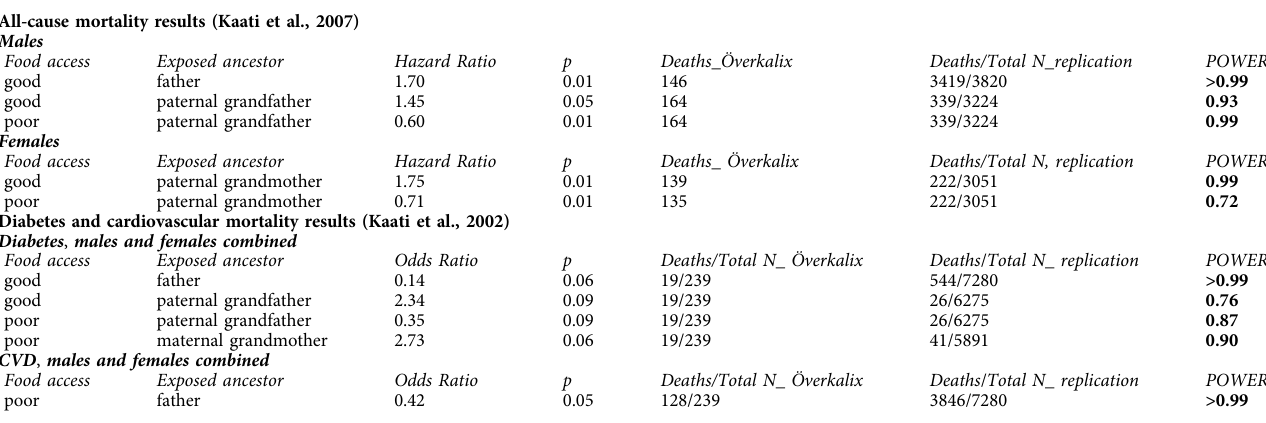
Supplementary Table 7: What is the power in our replication to detect the most important results in the Överkalix studies? All-cause mortality results (Kaati et al., 2007)